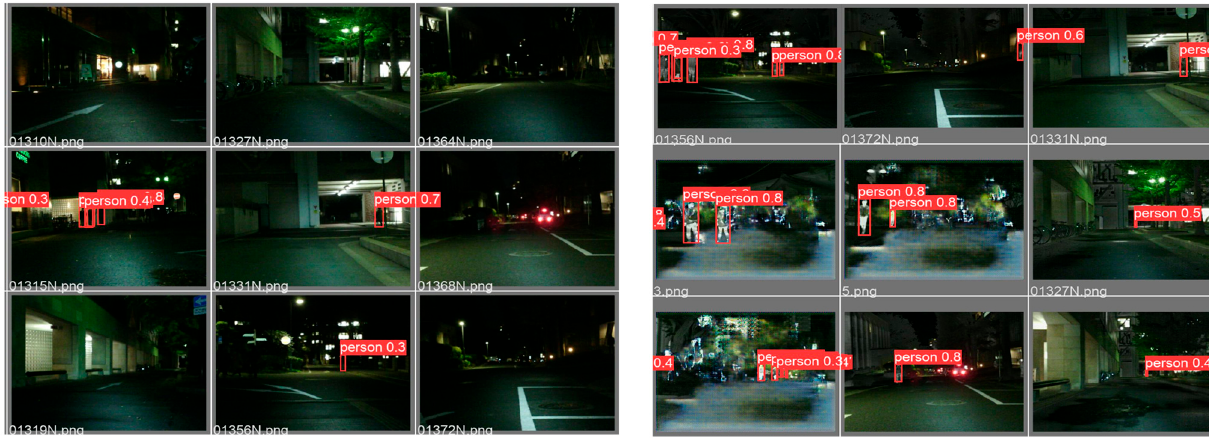
Figure 13. The visible image at night and the augmentation result.